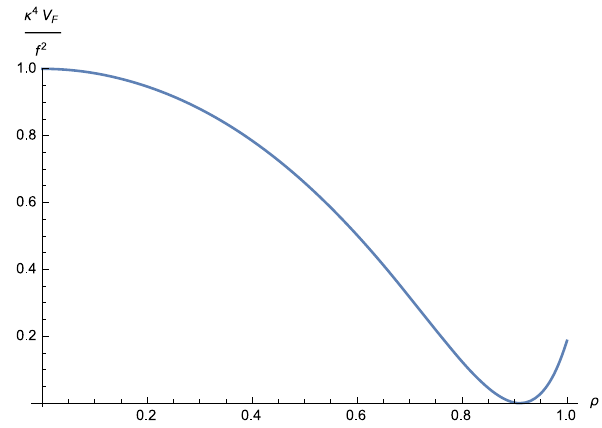
Fig. 1 A plot of the scalar potential given by Eq. (32) satisfying Eq.